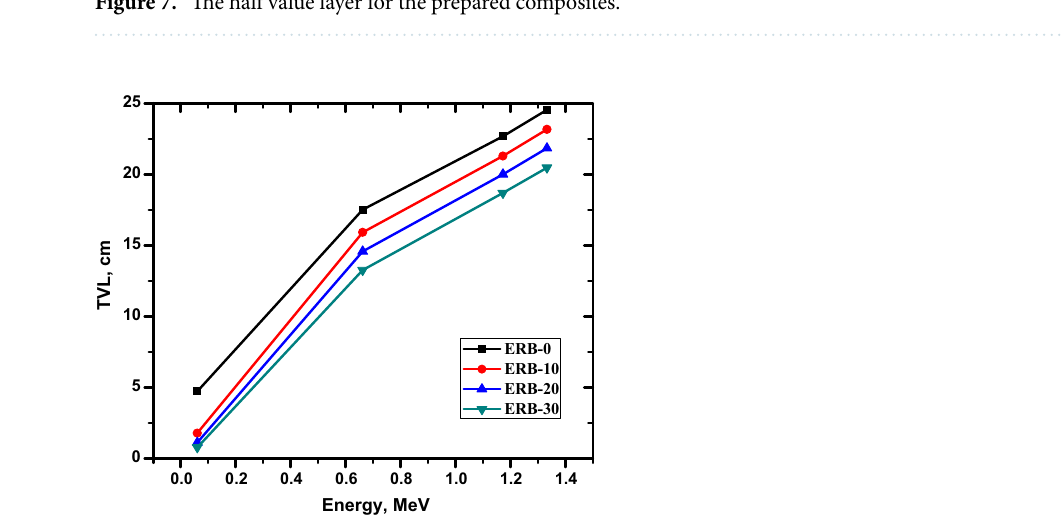
Figure 7. The half value layer for the prepared composites.